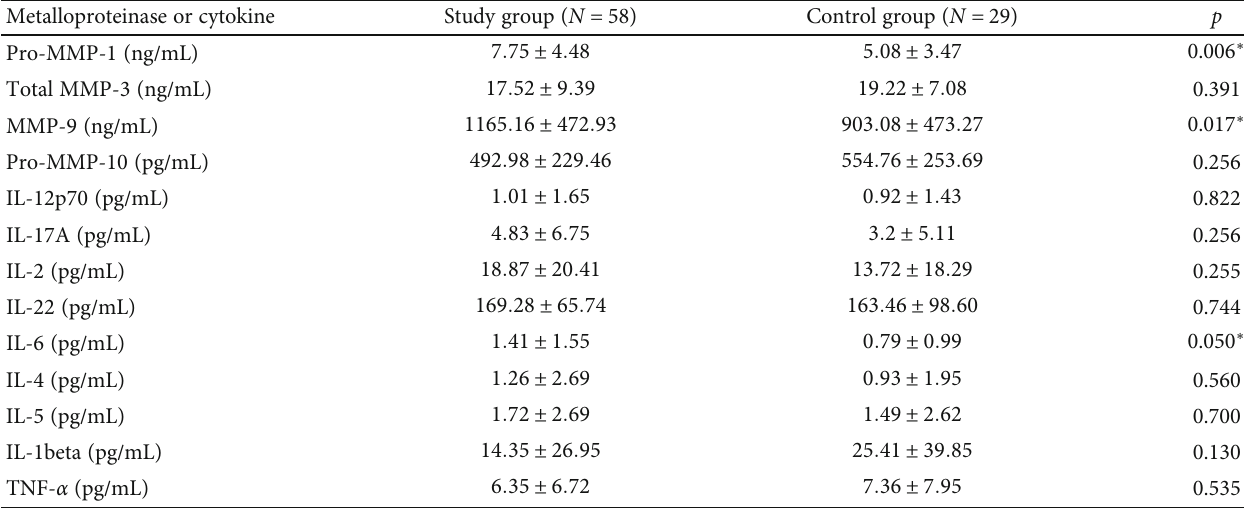
Table 2: Comparison of metalloproteinases and cytokines between psoriatic patients and control group. ∗ indicates statistically signi fi cant di ff erences.